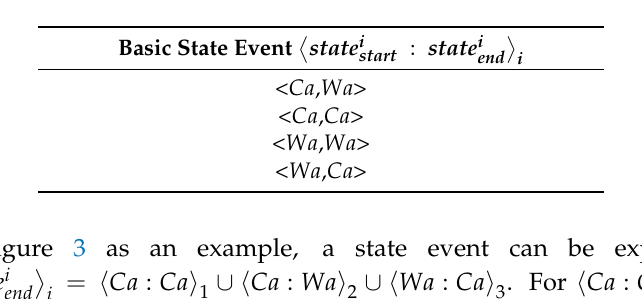
Table 1. Basic state